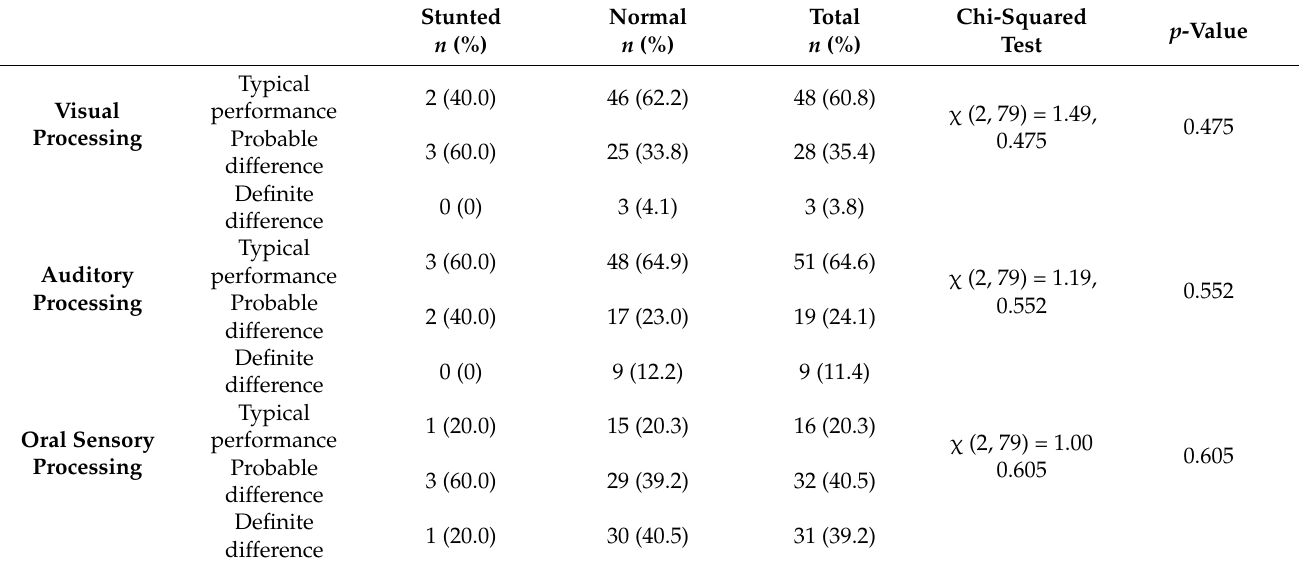
Table 3. Relationship between length/height-for-age anthropometric index (z-score) and sensory processing.